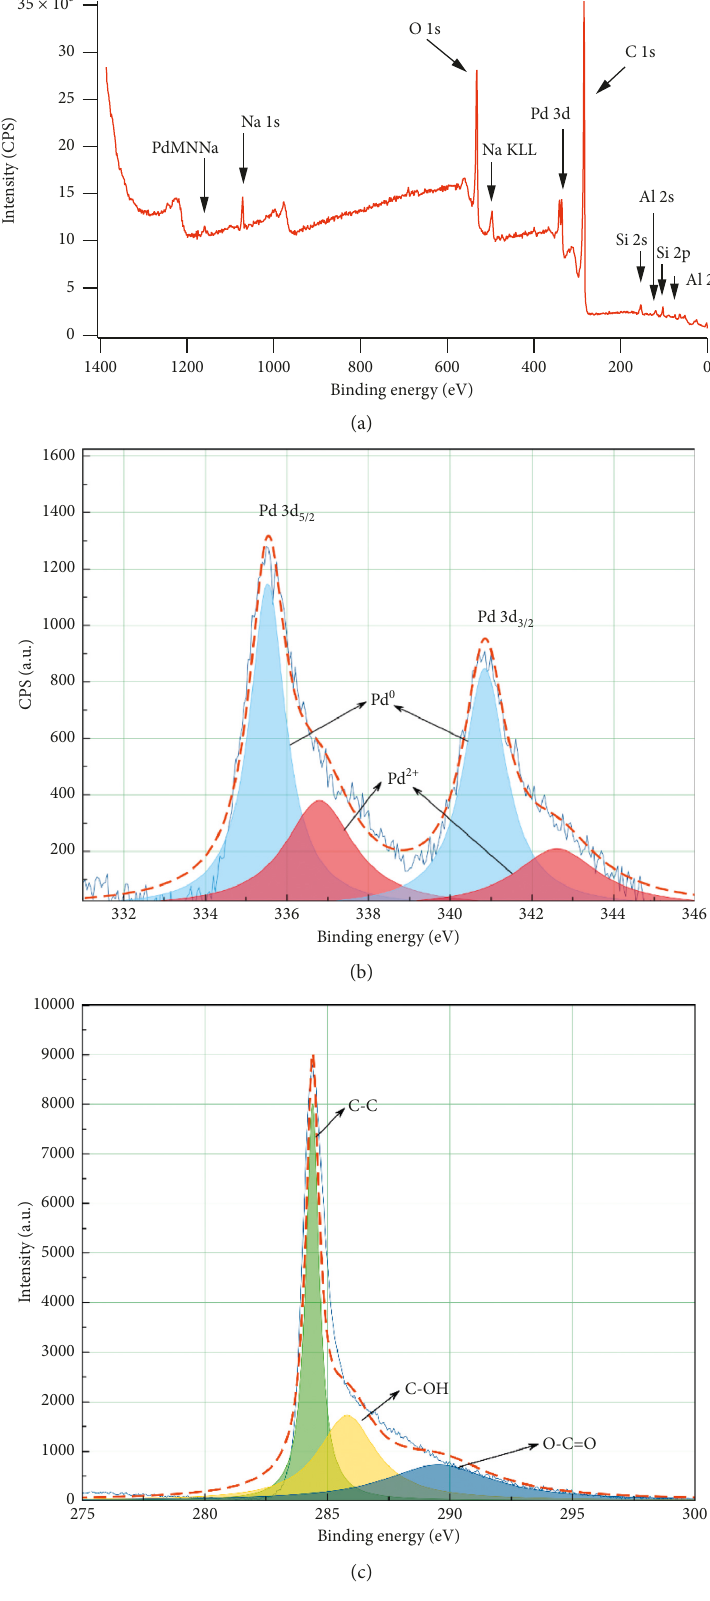
Figure 2: XPS spectrum (a), Pd 3d spectrum (b), and C 1s spectrum of the PASG.N catalyst